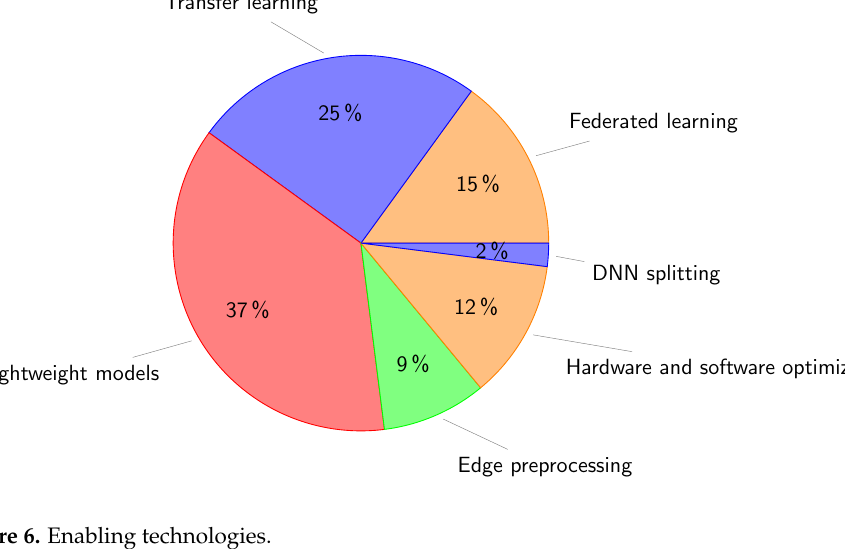
Figure 6. Enabling technologies.